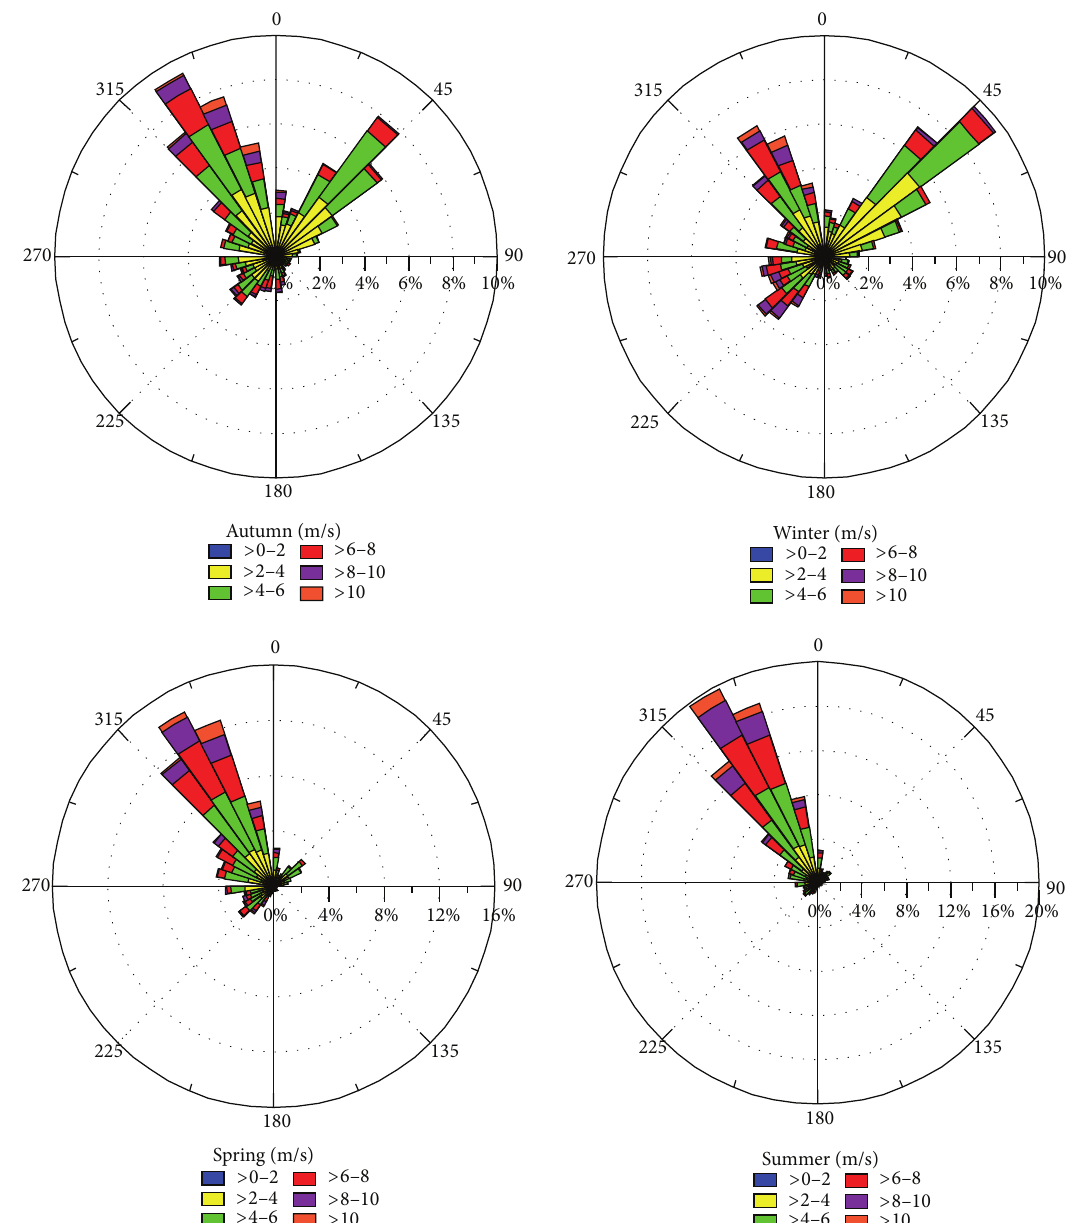
Figure 9: Seasonal regimes of wind speed and direction. Autumn: SON; Winter: DJF; Spring: MAM; Summer: JJA. Data: IPMA.